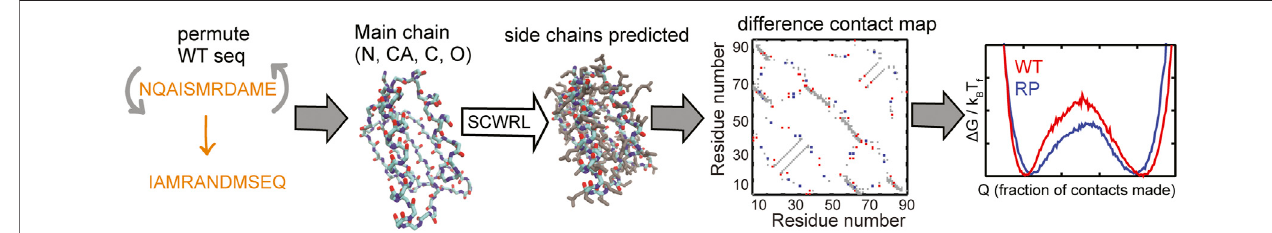
FIGURE 1 | A fl owchart of the RP method. The selected WT protein sequence (shown in orange) is randomly permuted. The side-chains are removed from the structureoftheWT protein but thebackboneatoms N (shownin blue),CA, C(both incyan)and O (red) areretained. The randomlypermutedsequence isput back onto this backbone using the program SCWRL. SCWRL predicts sidechain rotamers given the backbone structure and a sequence. The predicted side chains are shown in grey. Contact maps are calculated from both the WT and the randomly permuted protein structures. The difference contact map is shown here. The X and Y axes are indices on the residue number. A square marked at (x, y) implies that the residues x and y are in contact. This contact map is symmetric with the same information present on both sides of the x = y line, i.e., (x, y) and (y, x) represent the same contact. The grey contacts are common to both the WT and the random permutant (RP). Red contacts are present only in the WT and blue contacts are present only in the RP. C α -SBMs (see Methods) are constructed using the structure of the protein and these contact maps. Folding simulations of these SBMs are performed using molecular dynamics simulations and free energy pro fi les (negative logarithm of the